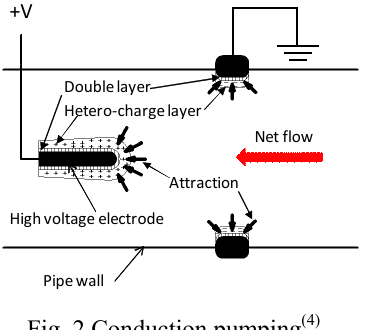
Fig. 2 Conduction pumping (4) Fig. 3 Conduction pumping with present electrode